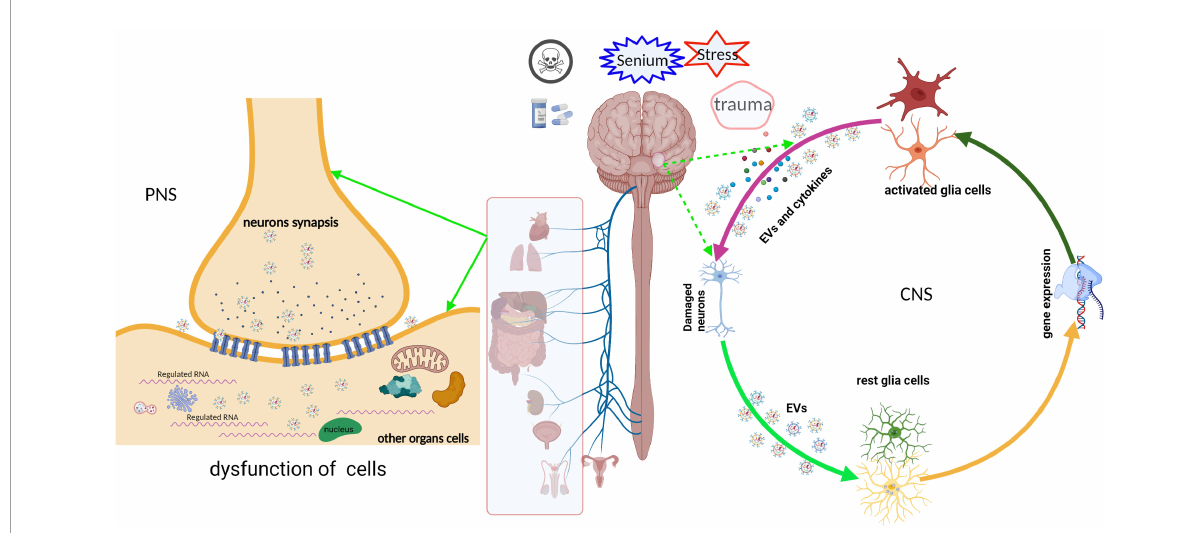
FIGURE2 Schematic representation of the neuronal EVs that regulated the function of receptor cells. EVs derived from neurons undergoing various stress deliver their cargoes, such as ncRNA, mRNA, or misfold proteins, into other cells in CNS or PNS via paracrine or active transport. These cargoes are abnormal expressions and are packaged into EVs, which disturb the gene expression or signal pathway of the recipient cells, ultimately leading to cell dysfunction. Meanwhile, dysfunctional recipient cells secrete “detrimental molecules” and then damage the neurons or nearby cells, and vice